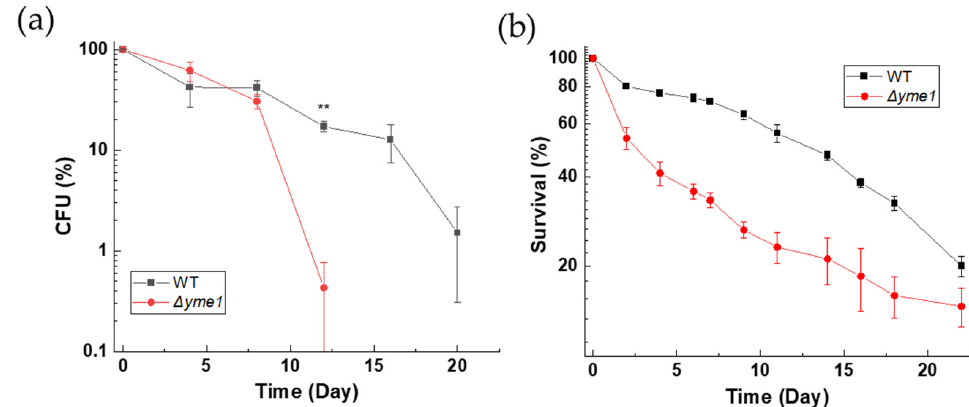
Figure 3. Effects of YME1 deletion on chronological life span of yeast cells. ( a ) Chronological life span (CLS) of yeast measured using a colony forming unit (CFU) count. WT and ∆ yme1 cells were inoculated into YPGal at 30 ◦ C for 2 days to reach stationary phase (day 0). Subsequently, aliquots of OD 600 = 0.1 cell suspension were spread on YPGal plates in the days indicated. Plates were incubated at 30 ◦ C for 2 days prior CFU count. Data represent percentage of CFU compared with day 0. ( b ) Chronological life span of yeast cells measured by flow cytometry coupled with propidium iodide staining. Cells were first grown in SCD media supplemented with 4-fold excess of uracil, leucine, tryptophan, adenine and histidine to reach stationary phase (day 0) before viability was assessed by PI staining and FCM analysis for three independent experiments. Data represent percentage of live cells relative to day 0 with relation to time. All error bars represent standard error of mean (SEM) of at least three independent experiments of two different cell cultures (n = 6). The statistic was done using Student’s t test, ** p < 0.01.